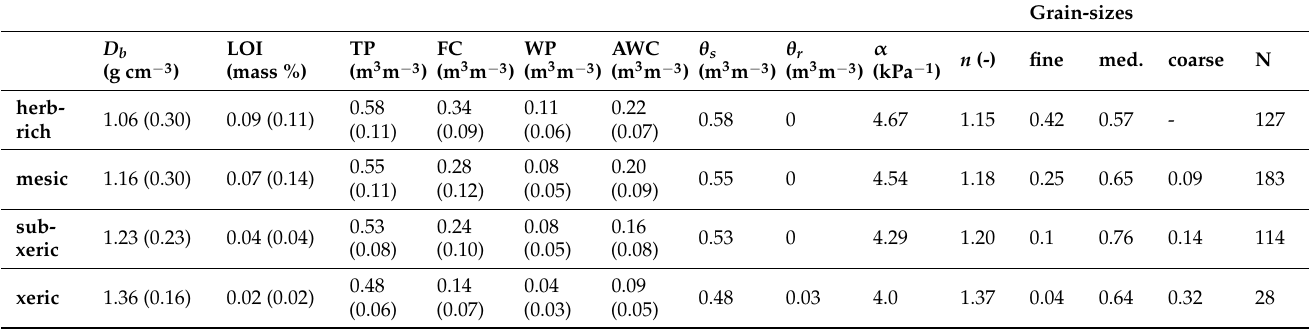
Table 2. Hydraulic and physical characteristics grouped by site type. Shown are the mean (std) of physical/hydrological properties and cluster-mean MvG water-retention curve parameters (See Supplementary Figure S2). Relative proportion of NFI grain-size observations within each site type is shown. N is the number of samples in each